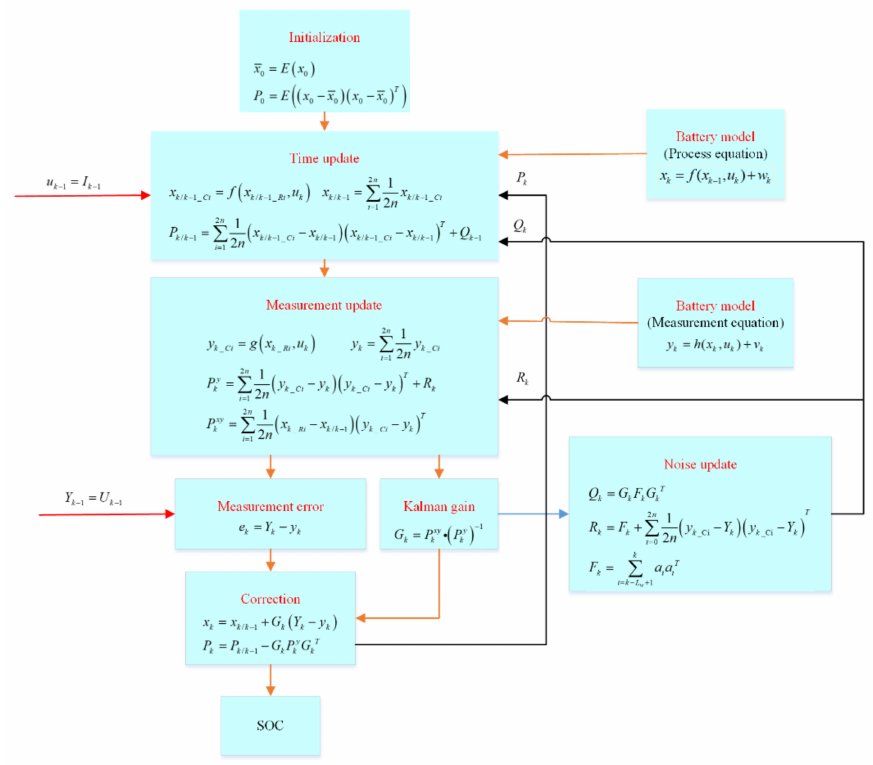
Figure 3. Diagram of SOC estimation based on